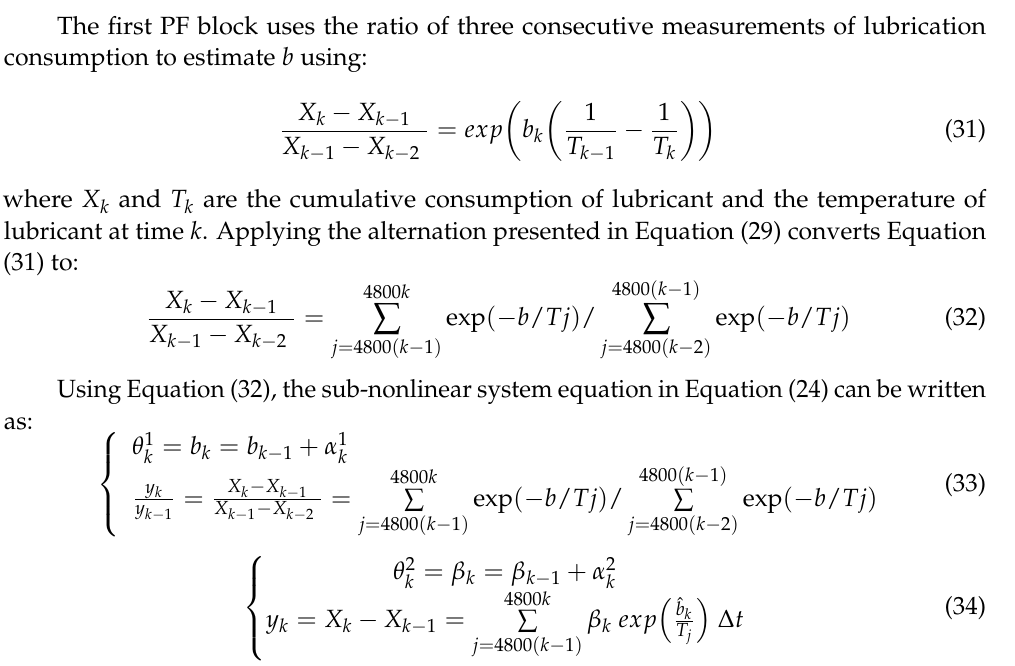
Figure 15. Result of the estimated lubrication consumption ( ˆ X k − ˆ X k − 1 ) using the one-step online parameter estimation